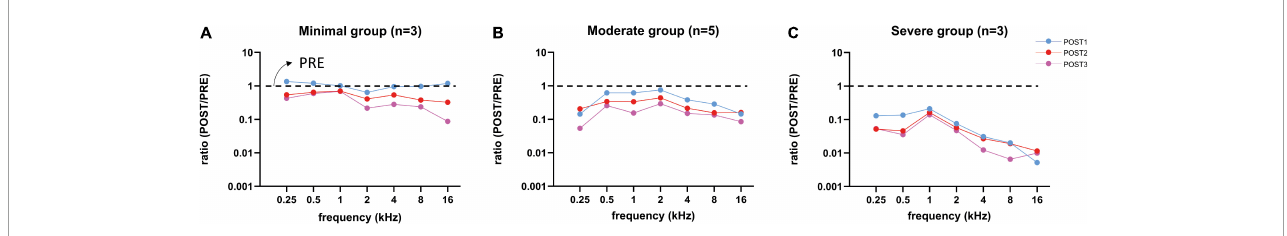
FIGURE8 Mean CAP amplitude ratios (POST/PRE) at ∼ 90 dB SPL of all three trauma groups are shown for each stage. After each stage, the amplitudes decreased for all three groups, except at POST1 stage in the minimal trauma group (A) . Responses of the moderate group (B) were affected more than in the minimal group and less than in the severe group. Responses to high frequency tones were severely affected, however also responses to low frequency tones were affected, especially in the severe trauma group (C) .